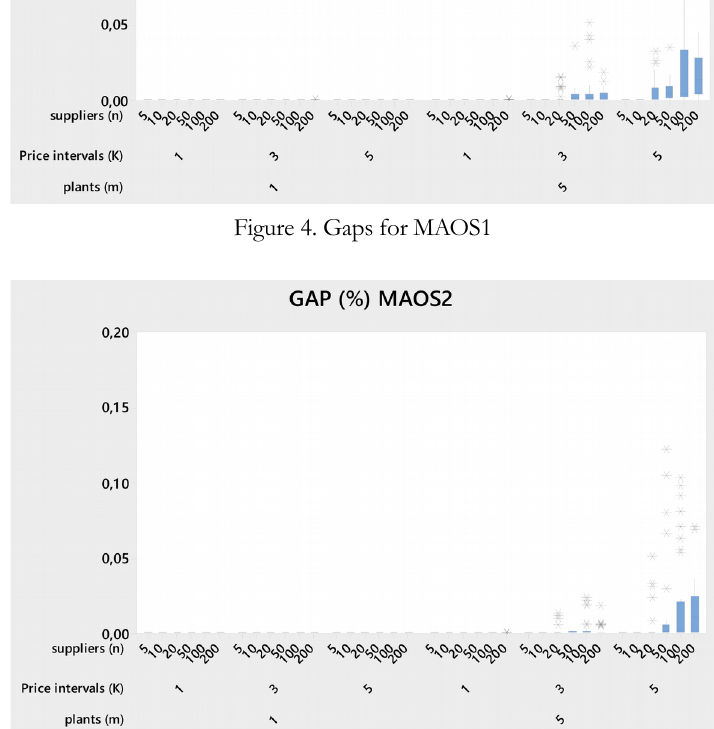
Figure 5. Gaps for